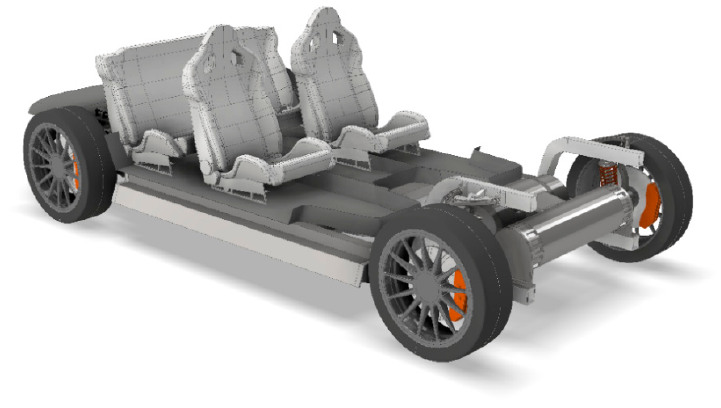
Figure 14. Vehicle 3D architecture CAD